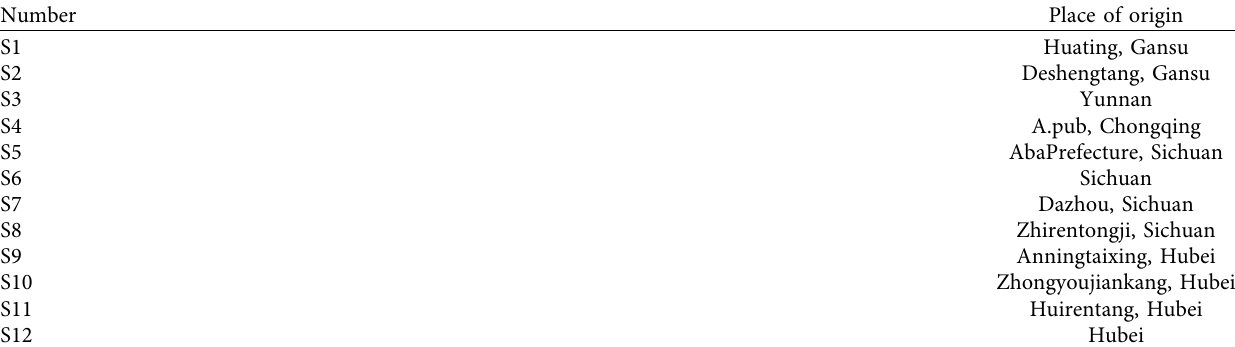
Table 1: Origin information of Angelicae Pubescentis